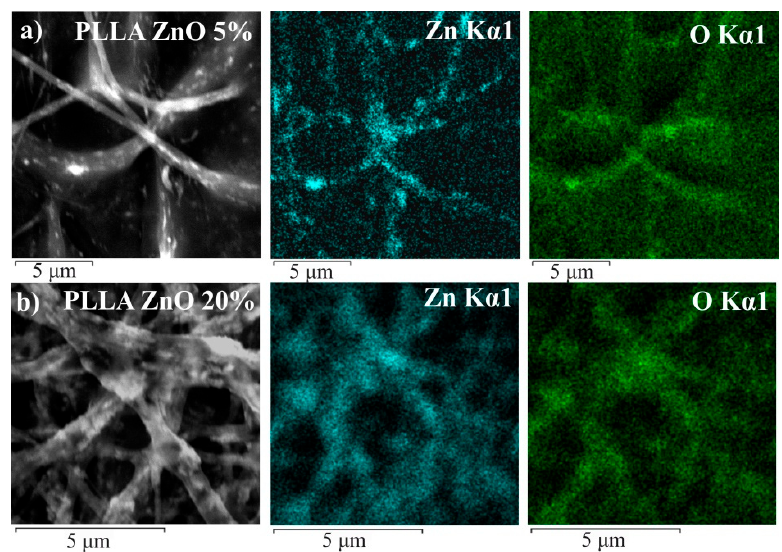
Figure 2. SEM images and corresponding EDX mapping for distribution of zinc (Zn K α 1) and oxygen (O K α 1). Data are presented for samples PLLA/ZnO_5% ( a ) and PLLA/ZnO_20% ( b ). Influence of ZnO NPs on the crystalline state of the electrospun fibers of PLLA was studied by means of XRD, with XRD patterns of undoped and ZnO doped PLLA mem- branes shown in Figure 3. The pattern of pure PLLA membrane (black line) is seen to exhibit two distinct diffraction maxima and around 17.1° and 19.3°, which correspond to the (200)/(110) and (203) planes of orthorhombic structure, respectively. Upon adding 5 wt.% of ZnO filler, the peaks of wurtzite ZnO are seen gradually to emerge in sample patterns, with their intensity increasing along the amount of incorporated ZnO NPs. At the same time, as well seen in the inset to Figure 3, the peaks of PLLA gradually decrease in intensity (see red, blue, pink, and green patterns that correspond to 5, 10, 20, and 40 wt.% of ZnO NPs). This observation clearly indicates that the increased content of incorporated ZnO NPs hinders crystallization of PLLA as NP aggregates limit the mobility of polymer chains [30].